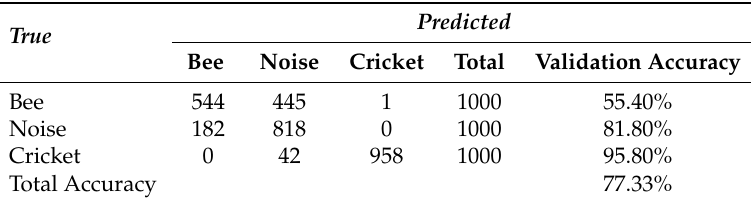
Table 22. Confusion matrix for SpectConvNet on BUZZ2 validation